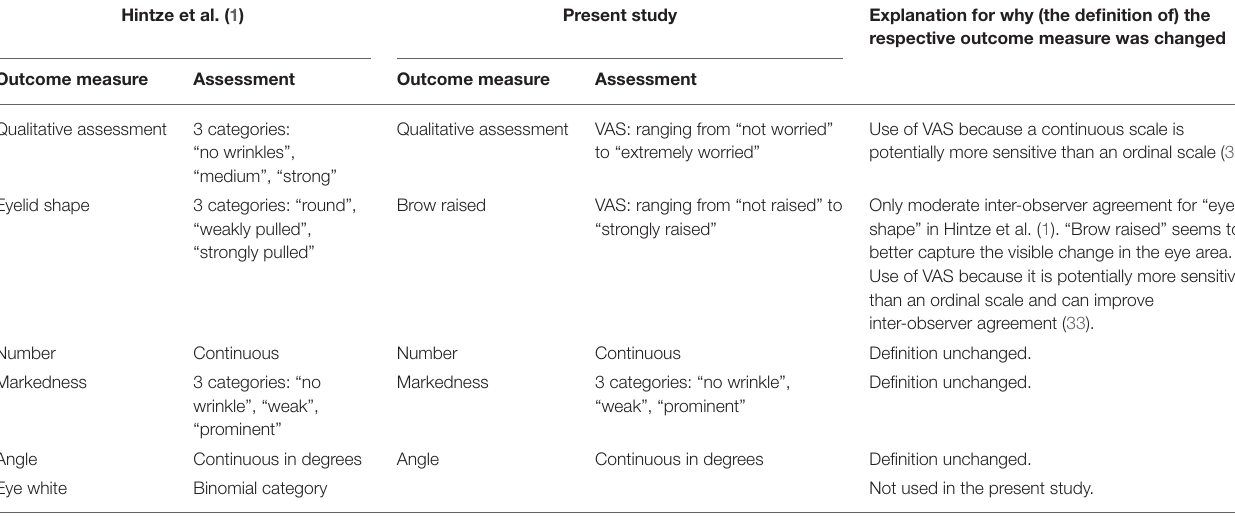
TABLE 1 | Comparison between the outcome measures used in the study by Hintze et al. (1) and in the present study. Hintze et al.